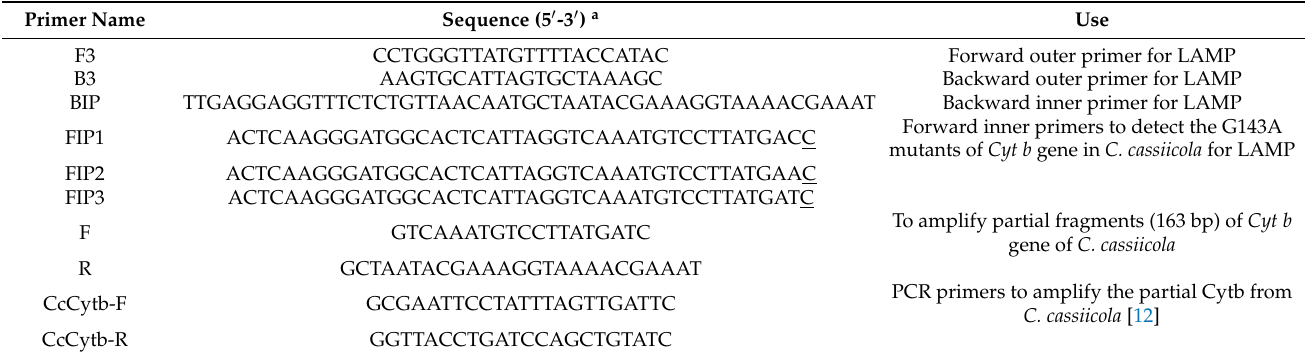
Table 1. Primers used for LAMP and partial Cyt b gene amplification from Corynespora cassiicola